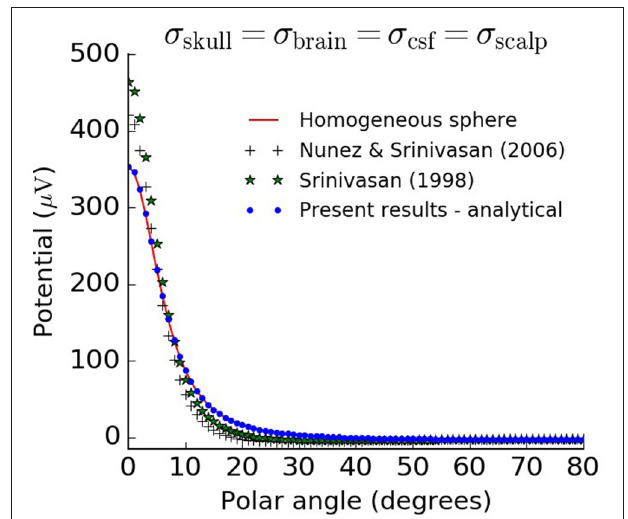
FIGURE 4 | Analytical solution of the four-sphere model satisfies control test for limiting case. Four-sphere model in the limiting case where the conductivity of the skull, CSF, and scalp are equal to the conductivity of the brain, compared to the equivalent model for a single homogeneous sphere, Equation (19). We used a radial dipole of magnitude 10 − 7 Am positioned a distance r z = 7.8 cm away from the center of the sphere, consistent with Figures 2 , 3